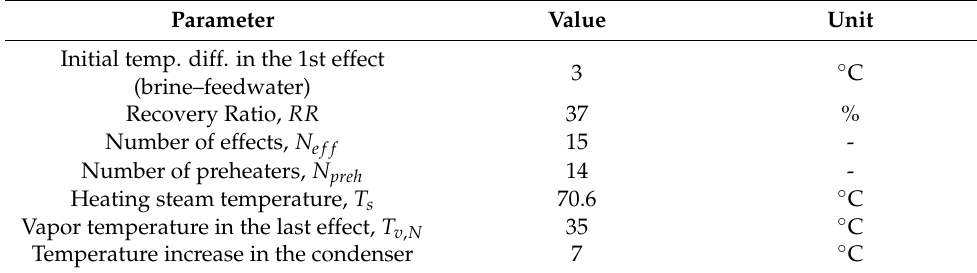
Table 3. Input data of the LT-MED